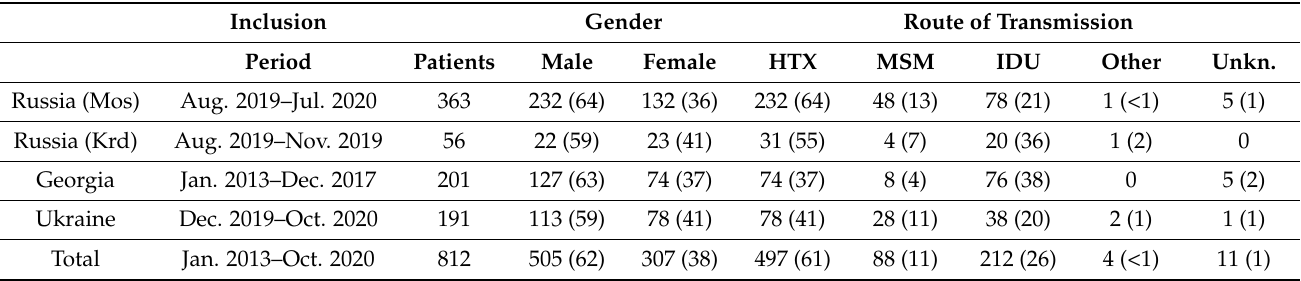
Table 1. Characteristics of HIV-1-infected patients from Russia, Georgia, and